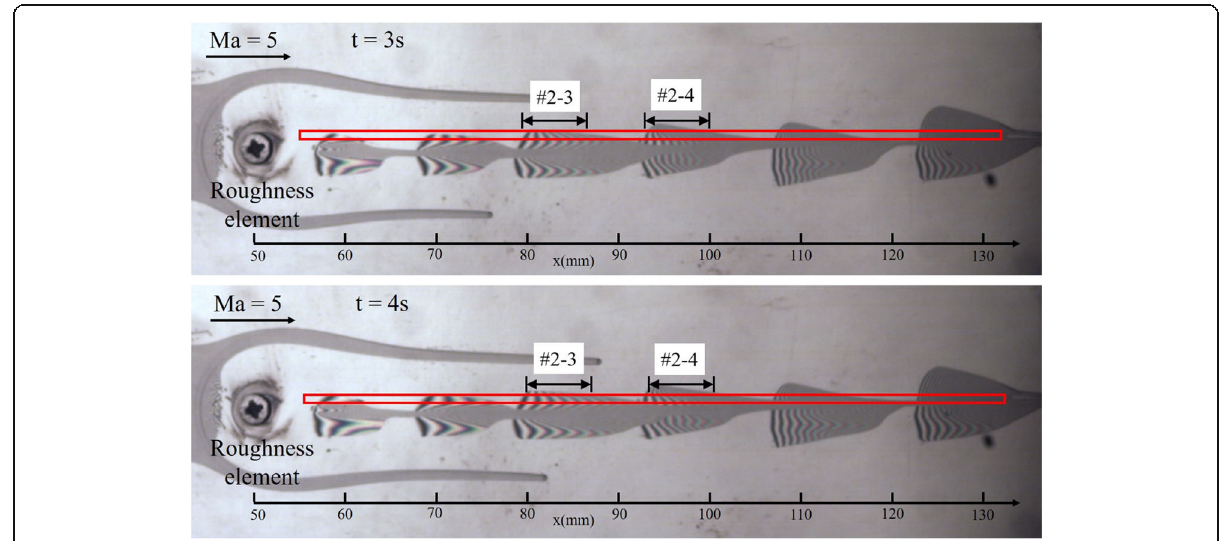
Fig. 9 Oil film pattern at t = 3 s and 4 s downstream of cylindrical roughness